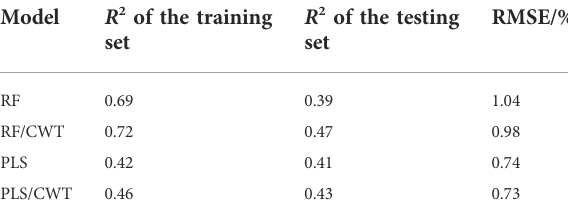
TABLE1Determinationcoef fi cientandrootmeansquarederrorofthe estimation